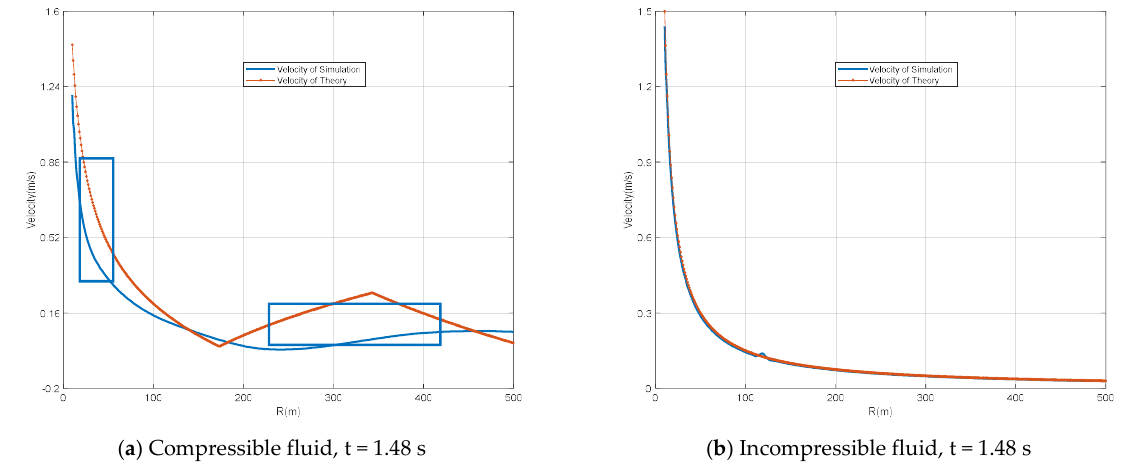
Figure 7. The plot of the velocity on the line X = 0, Y = (10,500) in case 2.